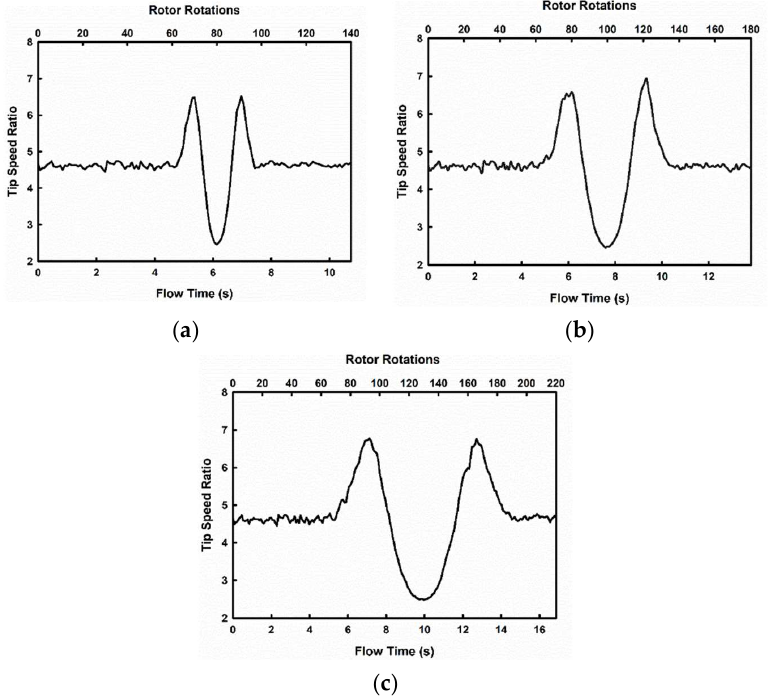
Figure 22. The variation of tip speed ratio (λ) for gust time periods ( a ) 3 s; ( b ) 6 s; ( c ) 10.5 s. Figure 23 shows the variation of C p for flow time for one complete gust cycle for the same U gust = 10 m/s and gust time periods 3 s, 6 s, and 10.5 s, respectively. The trend is similar in all three cases, but the max C p values are 0.64 for a time period of 3 s and 0.71 for the time periods of 6 s and 10.5 s. This difference is due to the rapid rise and fall time of the gust signal for the time period 3 s case. In Figure 22c, it is observed that there are many fluctuations of C p from the flow time 9 s to 10.5 s. The variation of C m with the azimuthal angle for different turbine cycles is similar in all gust time period cases as represented in Figure 24, attributing to the same gust amplitude of 10 m/s.